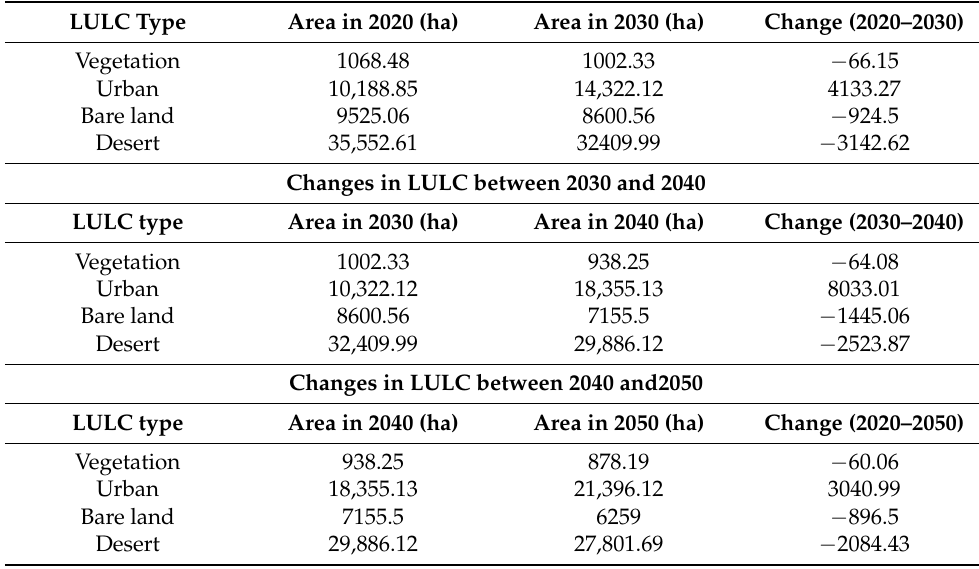
Table 6. Changes in LULC between 2020 and